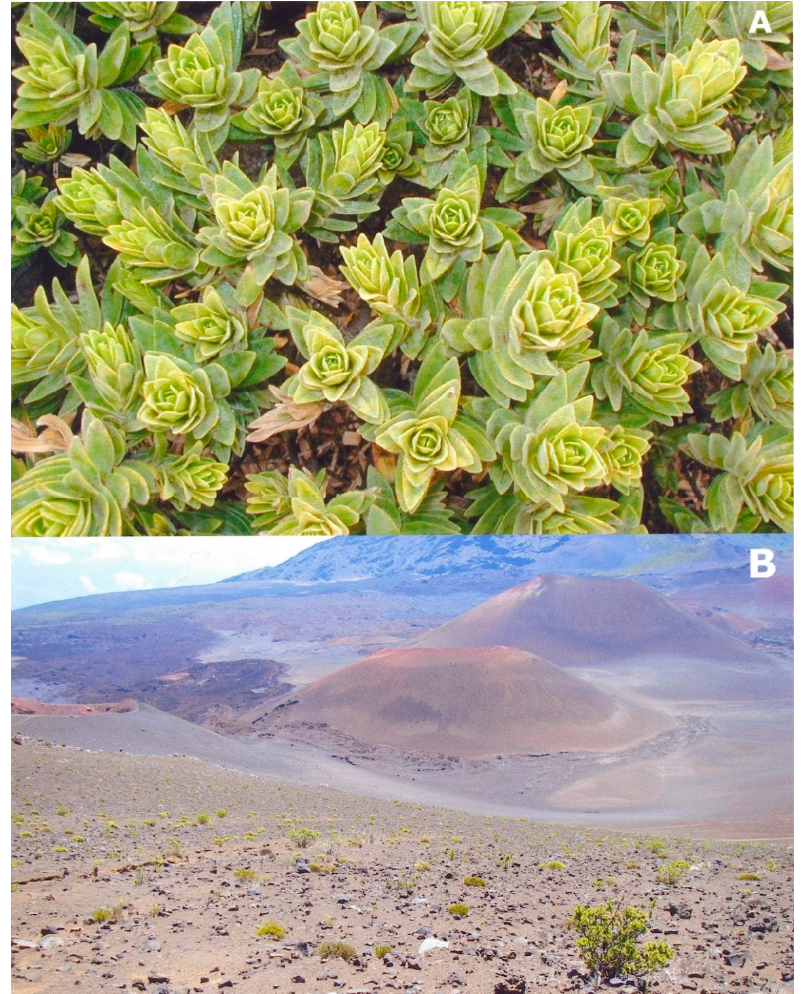
Figure 1. ( A ) Close-up of densely packed k ū paoa foliage; note the tightly overlapping, small imbricate leaves; area shown is ~35 cm wide. Photo: Hk-591-02, 7 August 2002. ( B ) View of the study site, ~2675 m, ~11° gradient, looking north toward the Ko’olau Gap—seen on the upper left. Several large cinder cones rise from the crater floor, (~2300 m), including Ka ma’o li’i (center), and Pu’u o M ā ui (summit: 2479 m, upper right). Note the many pyroclastic blocks littering the ground, and the hundreds of shrubs across the extensive slope on the crater walls. Photo: Hk-24-11, 26 June 2011.